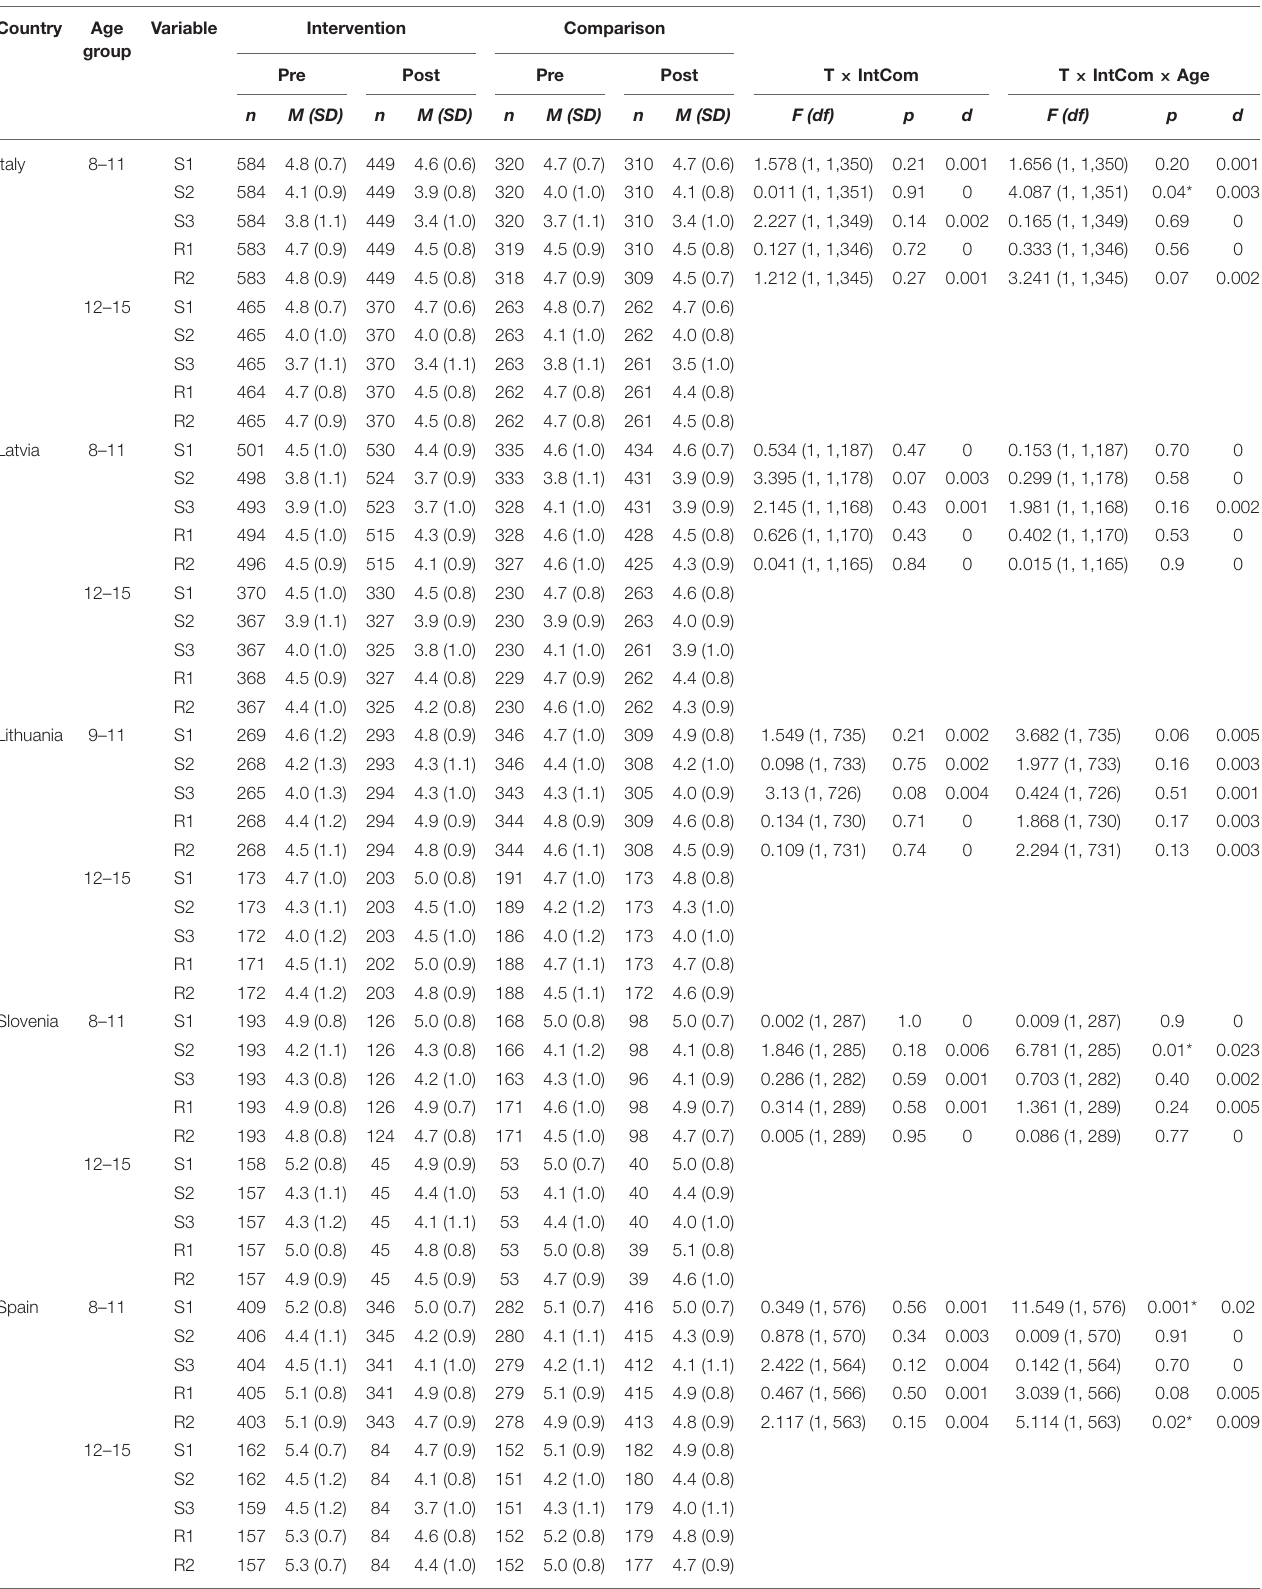
TABLE 6 | Number of participants, mean values, standard deviations and interaction effects of all variables of SEL country by country in alphabetical order. Country Age group